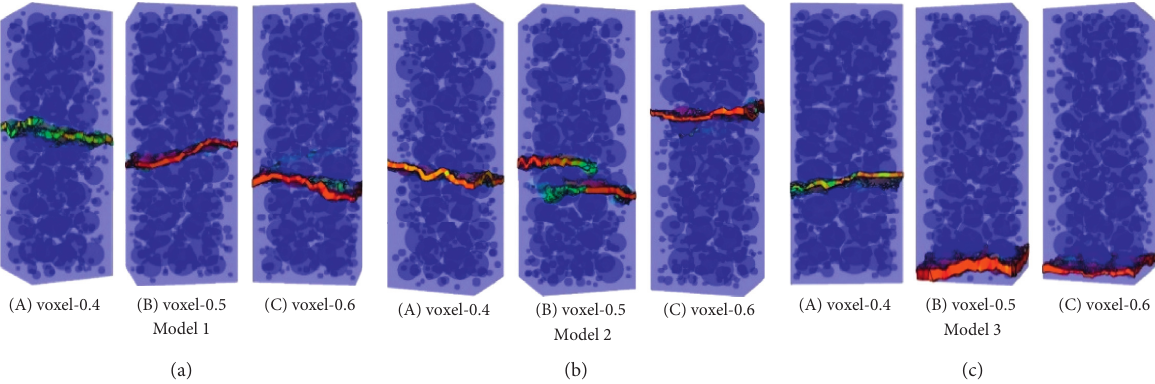
Figure 5: Crack patterns of varying mesh size models. (a) Model 1. (b) Model 2. (c) Model 3.